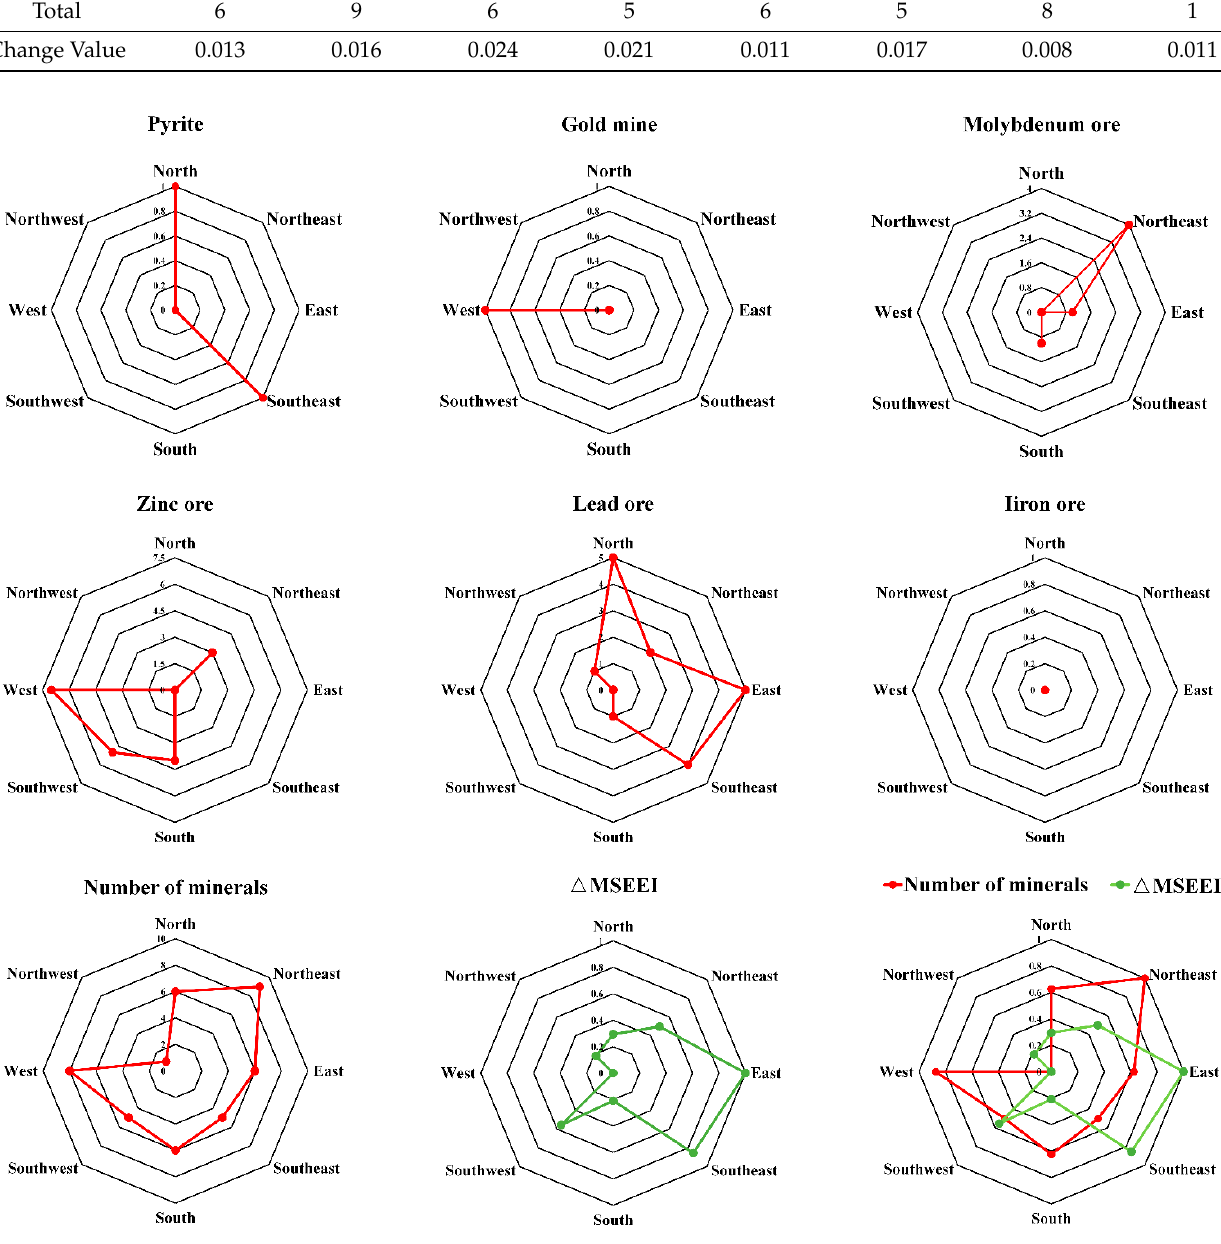
Figure 13. The spatial pattern of MSEEI change around the ore points.